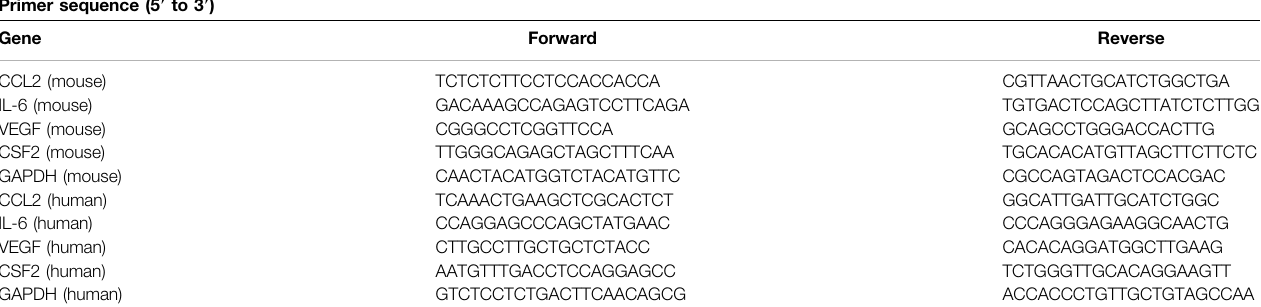
TABLE 1 | The primers used for determination of mRNA levels in mice and human hepatocytes. Primer sequence (5 9 to 3 9 )